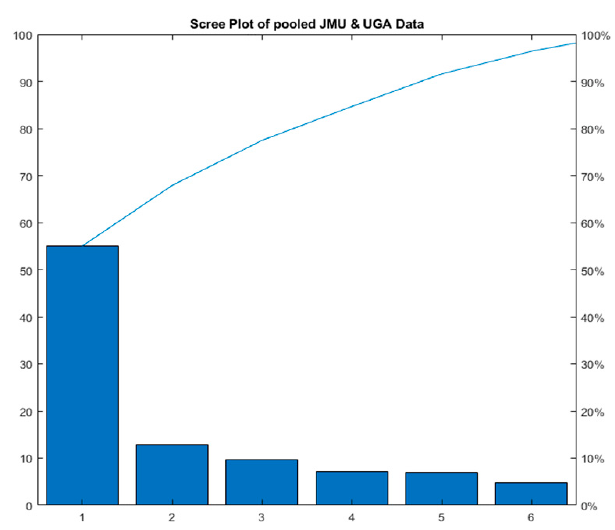
Figure 3. Scree plot of pooled JMU and UGA datasets to decide number of principal components.